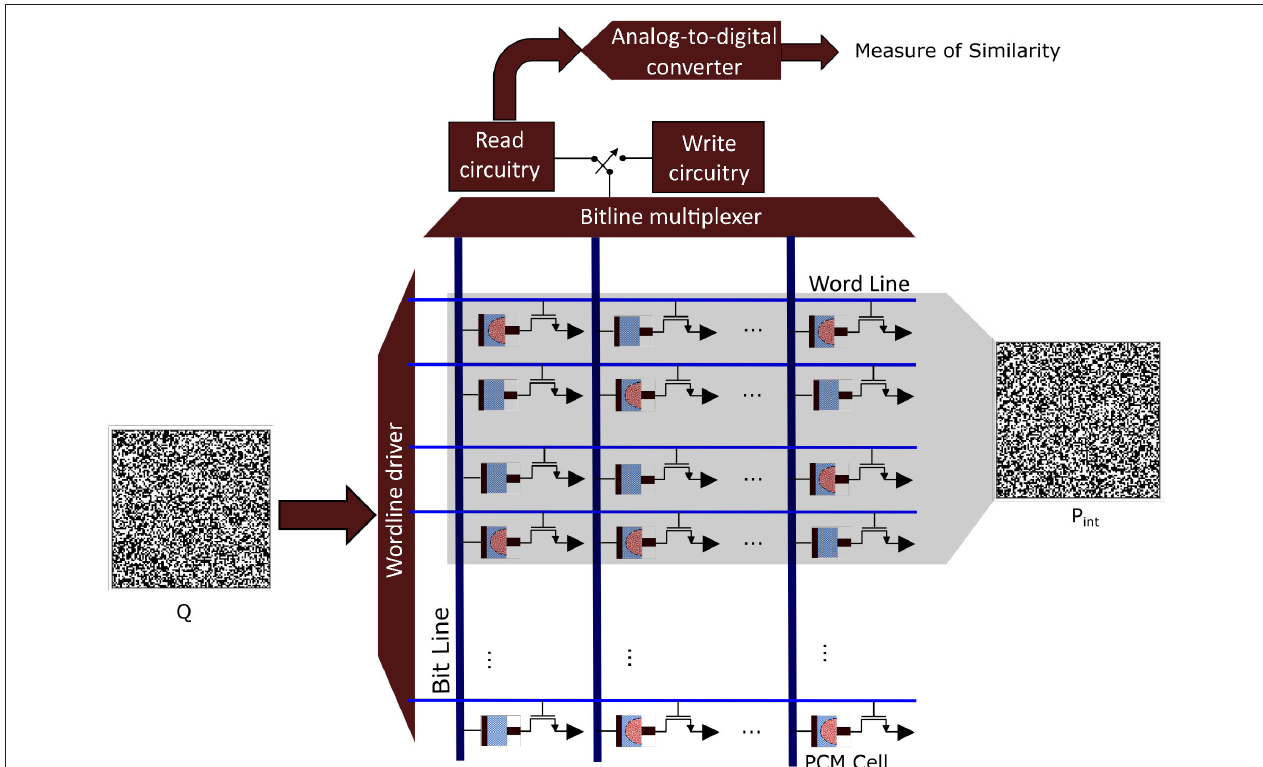
FIGURE 7 | Analog in-memory computing hardware based on phase change material (PCM) devices that are arranged into a crossbar array. In a programming phase, each binary prototype hyperdimensional (HD) vector ( P int or P ict ) is written into 10,000 PCM cells. This programming is done by applying a write voltage that changes the conductance state of the PCM cells according to the corresponding binary HD vector component. For classification, the query binary HD vector ( Q ) is applied to the crossbar array, and its similarity is measured with the programmed